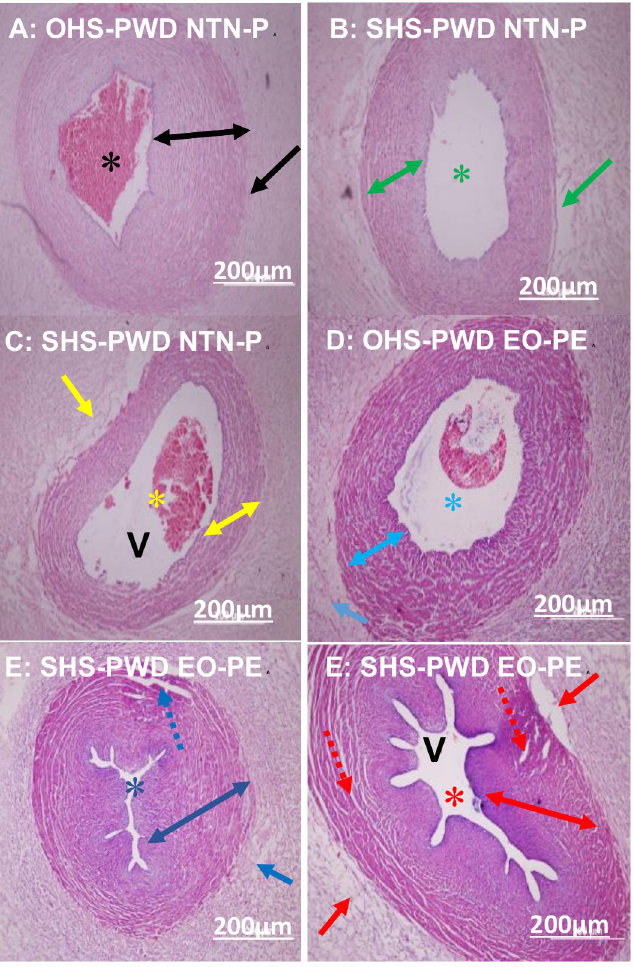
Fig 3. Photomicrographs of umbilical cord artery and vein of SHS and OHS-PWD EO-PE and LO-PE compared to NTN-P placentae. A: intact tunica media of umbilical cord artery (double black arrow) with large lumen (black asterisk) and intact musculostromal architecture (black arrow) of OHS-pregnant women who experienced NTN-P at 40 weeks (magnification x20). B: intact tunica media of umbilical cord artery (double green arrow) with large lumen (green asterisk) and moderate disruption of musculostromal architecture (green arrow) in SHS- pregnant women who experienced NTN-P at 38 weeks (magnification x20). C: intact umbilical cord vein (double arrow) with large lumen (yellow asterisk) and a moderate disruption of musculostromal architecture (yellow arrow) in SHS- pregnant women who experienced NTN-P at 38 weeks (magnification x20). D: intact tunica media of umbilical cord artery with large lumen (sea blue asterisk), few disruptions of musculostromal architecture (sea blue arrow) and a massive vascular wall fibrin deposition (double sea blue arow arrow) in OHS- pregnant women who developed EO-PE at 33 weeks (magnification x20). E: narrowed lumen (deep blue asterisk), few disruptions of the endothelium (deep blue line arrow), vascular wall hypertrophy with vascular wall fibrin depositions (double deep blue arrow) in SHS- pregnant women who developed EO-PE at 32 weeks (magnification x20). F: narrowed lumen umbilical vein (red asterisk), moderate disruption of the endothelium (red line arrow) and musculostromal architecture (red arrow), vascular wall hypertrophy with vascular wall fibrin depositions (double red arrow) in SHS- pregnant women who developed EO-PE at 32 weeks (magnification x20). Scale bar = 200 μ m. https://doi.org/10.1371/journal.pone.0265717.g003 PLOS ONE | https://doi.org/10.1371/journal.pone.0265717 March 21,